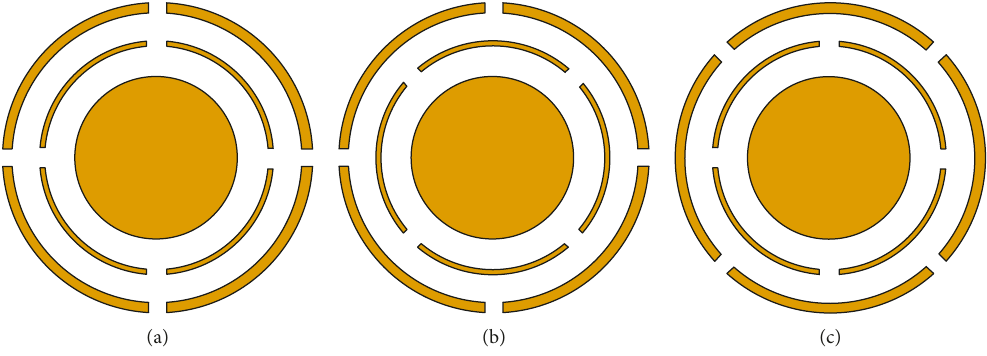
Figure 7: Different locations of the gaps on the two APMSs. (a) Gap 1. (b) Gap 2. (c) Gap 3.